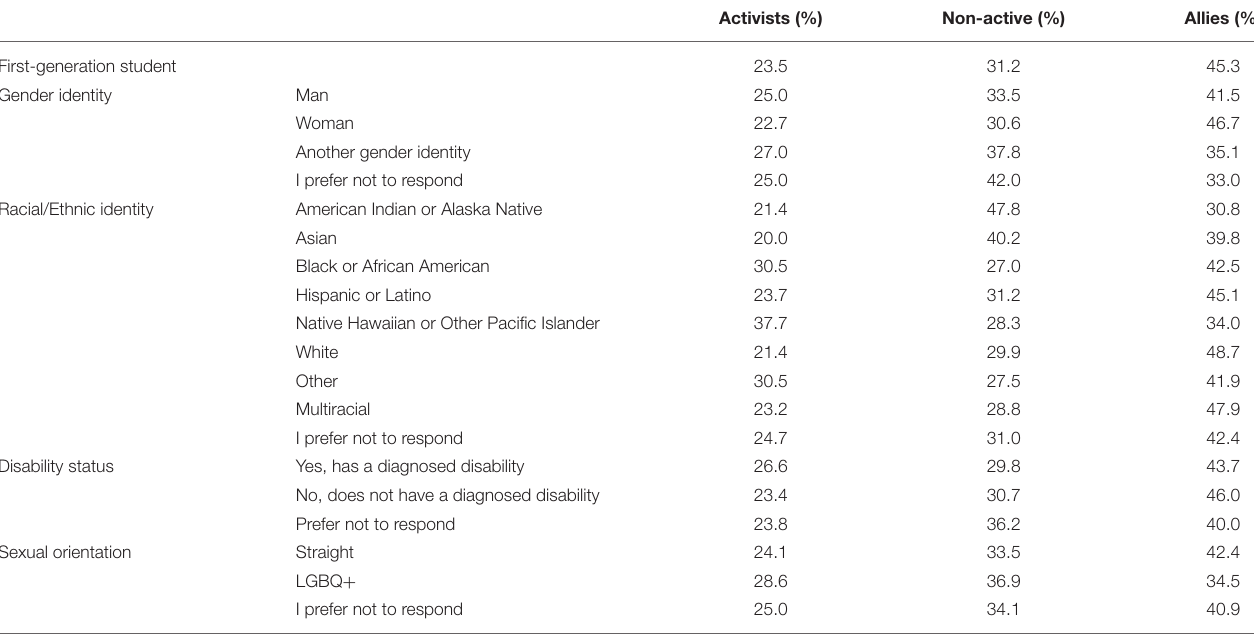
TABLE 4 | Select identity characteristics by civic engagement student groups.